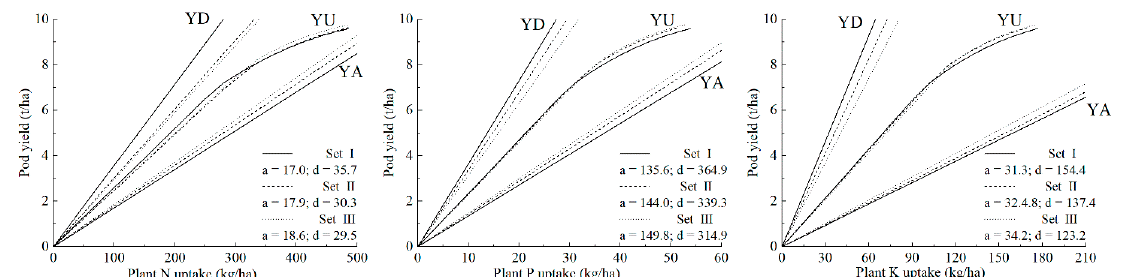
Figure 3. Peanut pod yields in relation to the plant nutrient uptake at different ( a , d ) constants. In the figure, the calculations excluded the upper and lower 2.5th (Set I), 5th (Set II), and 7.5th (Set III) percentiles of all the IE data (HI range from 0.4 to 0.82); YD, YA, and YU represent the maximum dilution, maximum accumulation, and balanced uptake of N, P, and K in plant dry matter, respectively; Potential yield was set at 10 t/ha.